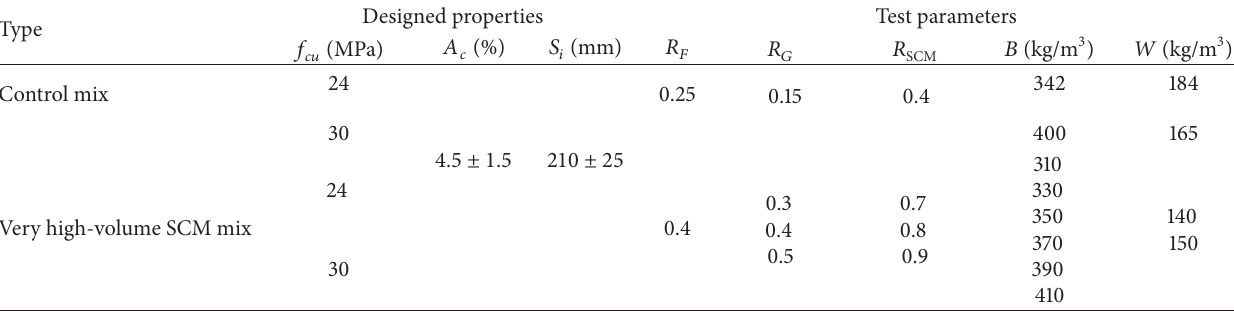
Table 3: Designed properties and main parameters of concrete